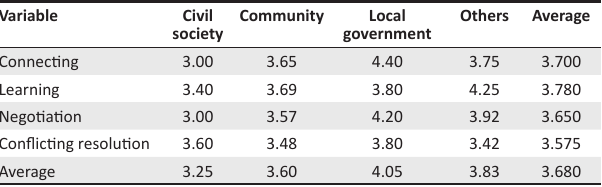
TABLE 3: Participants views on knowledge and learning of risk.